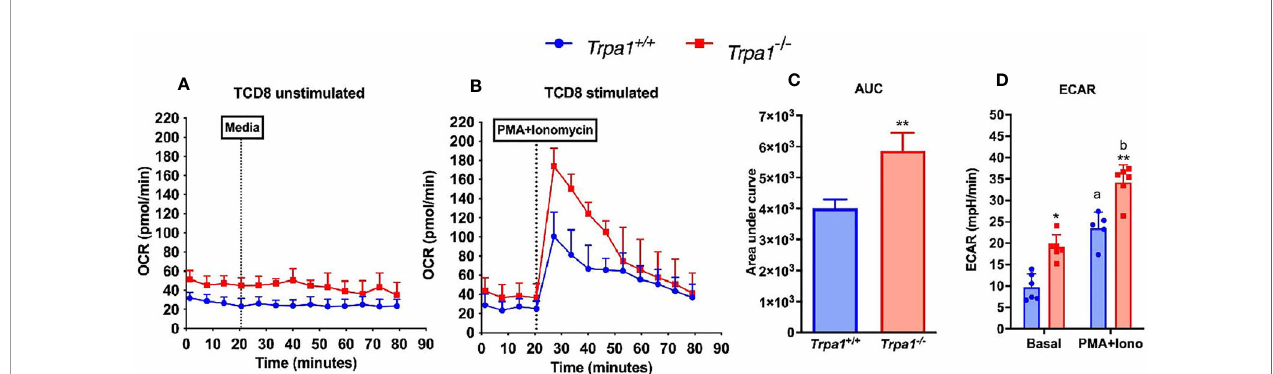
FIGURE 5 | Metabolic parameters from spleen-derived Trpa1 +/+ or Trpa1 -/- T CD8 lymphocytes. (A) Basal unstimulated levels of oxygen consumption rate (OCR) of freshly isolated T CD8 cells; (B) OCR levels of T CD8 exposed to a cocktail with ionomycin and PMA compared to the basal rate; (C) Area under the curves of B; (D) Extracellular acidi fi cation rates (ECAR) for both non-stimulated and stimulated cells from the two groups. Values are presented as the mean (n = 8) ± SD of each group. Statistical analyses were performed by Student ’ s t -test in C and by One Way ANOVA followed by Tukey in (D) Each well contained 100,000 cells. *p < 0.05; **p < 0.01 between genotypes. Difference between the different conditions within the same genotype is represented by letters a ≠ b, p < 0.05.